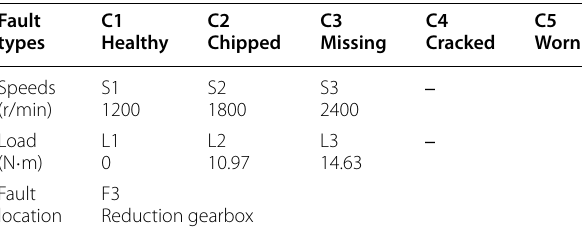
Table 1 Gear fault type and working